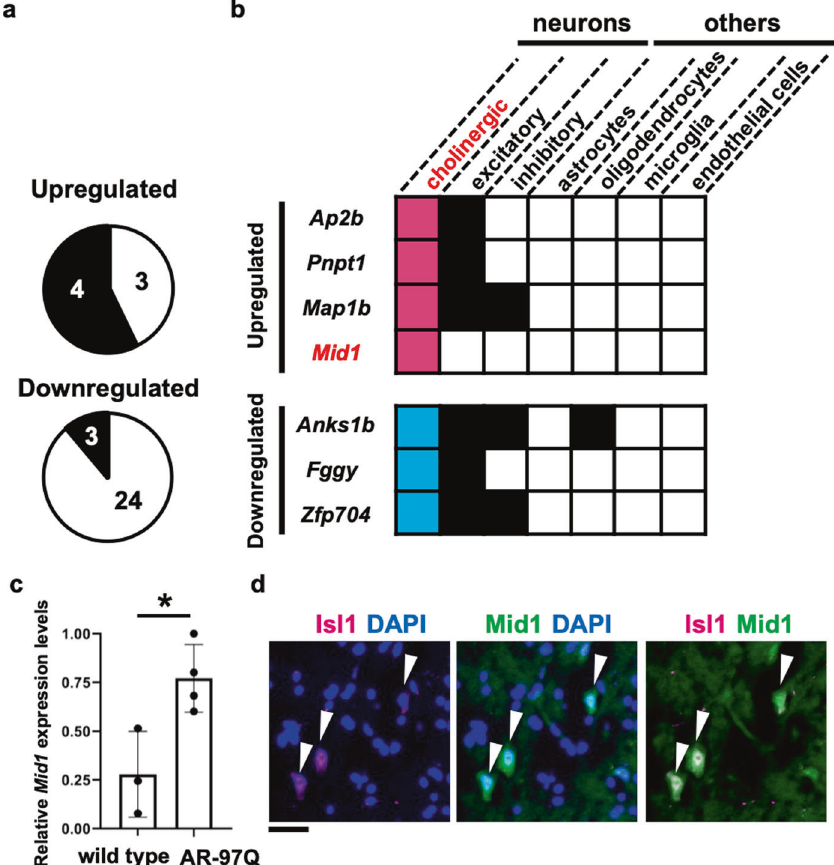
Fig. 1 Mid1 as a candidate gene associated with motor neuron vulnerability in SBMA. a The spinal cord transcriptome data of SBMA mice [4] contained seven upregulated and 27 downregulated genes. Analyses of these genes in single-cell transcriptional atlas [27] identi fi ed four upregulated and three downregulated genes expressed in the cholinergic neurons in the spinal cord of adult mice. b A binary matrix summarizing the expression of the genes in the other cell types in the spinal cord using the single-cell transcriptional atlas [27]. The expression was indicated by the fi lled matrices. c Relative quanti fi cation of Mid1 expression in the spinal cord of AR-97Q mice at 12 weeks of age (* p < 0.05, unpaired two-tailed two-sample t -test). d Immunostaining of Mid1 in the spinal cord of the mouse at 10 weeks of age. Isl1 is a motor neuron marker. Scale bar 50 μ